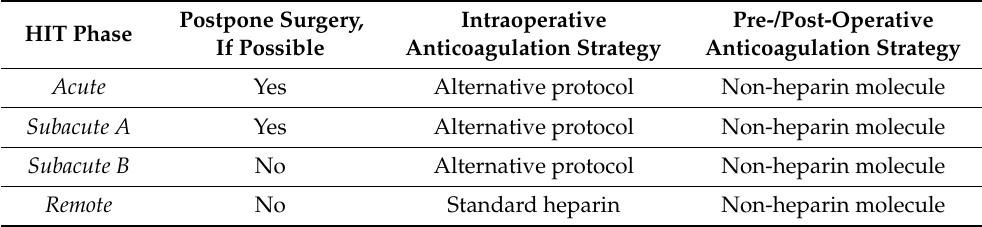
Table 1. Perioperative strategies depending on HIT clinical